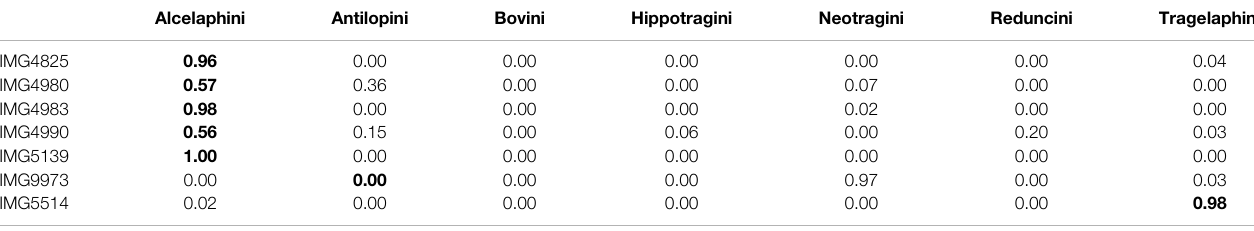
TABLE3| Realdata .Tribelevelpredictedclassprobabilitiesfromtheknn-impclassi fi erwith k n (cid:2) K (cid:2) M (cid:2) 10.Emboldenedvaluesindicatethe “ true ” classasobtainedfroman expert.